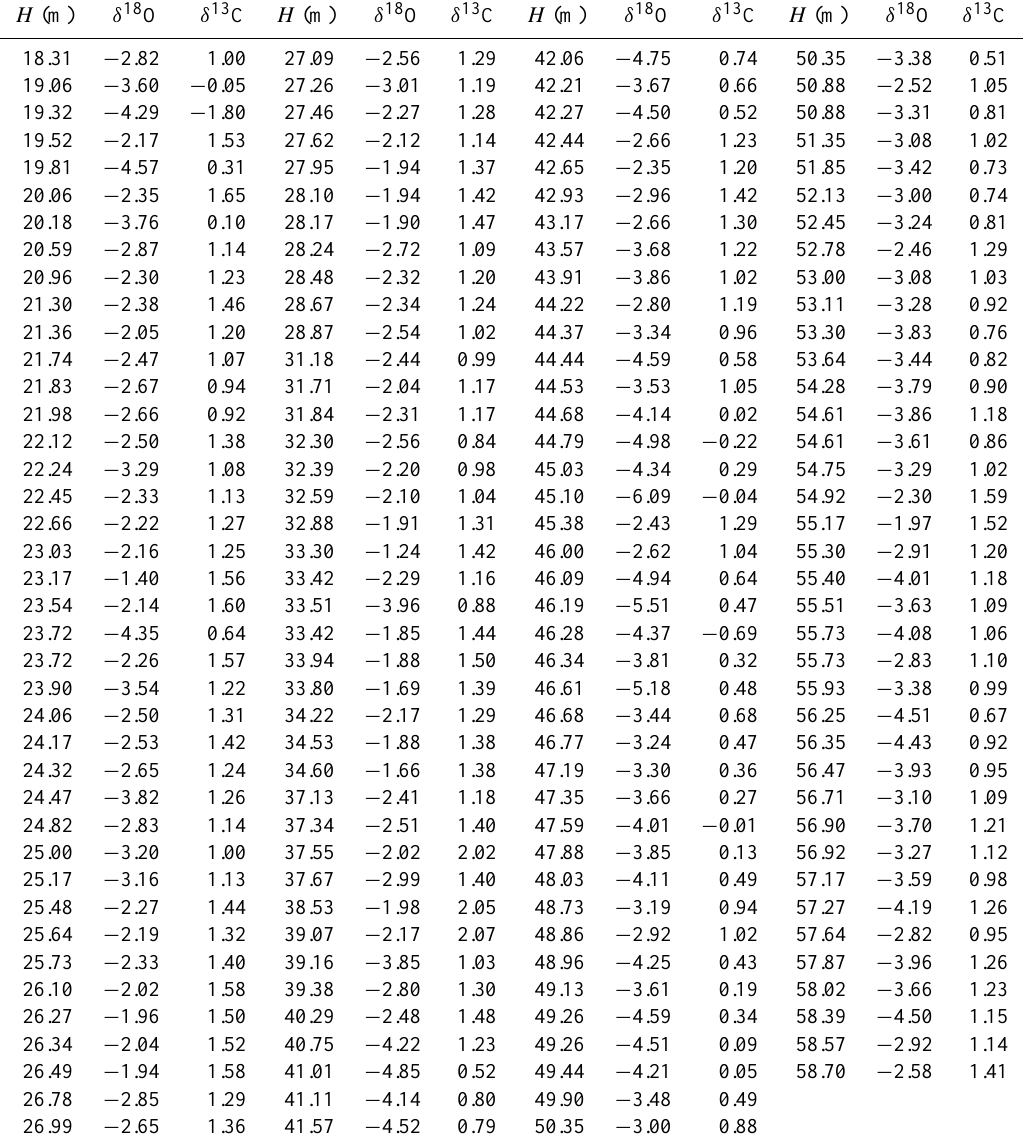
Table 4. Stable isotope composition of oxygen and carbon in limestones of the Pizzo Mondello section. Stratigraphic heights ( H ) as in Fig.